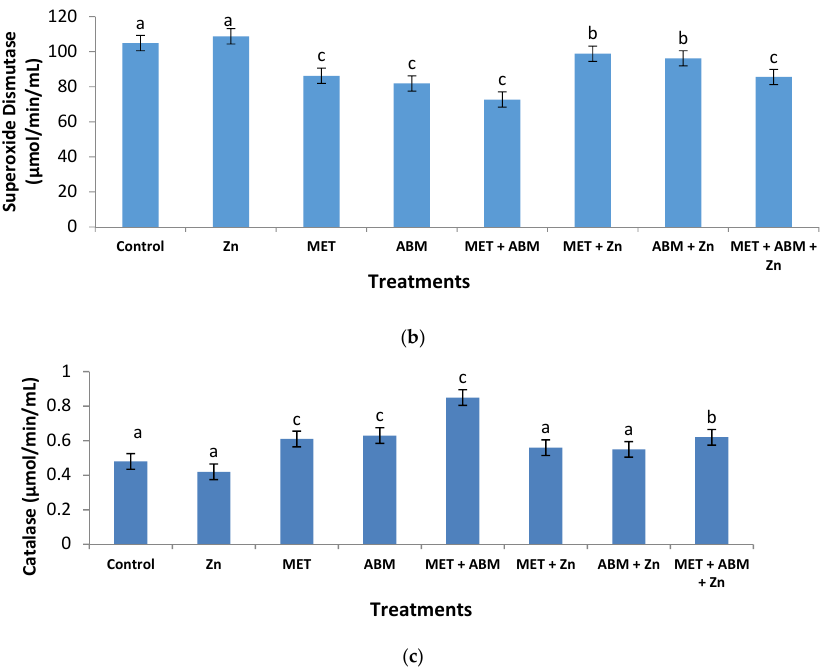
Figure 2. Effect of methomyl (MET), abamectin (ABM), and their mixture (MET+ABM), with and without zinc (Zn), on levels of malondialdehyde (MDA), superoxide dismutase (SOD), and catalase (CAT) in the plasma of male rats. Statistics: narsrepresent the group means ± SD; n = 8. Values of similar superscript letters are not statistically different. Values of superscript “b” are significantly different than those of superscript “a” at p ≤ 0.05; Values of superscript “c” are high significantly different than those of superscript “a” at p ≤ 0.01. ( a ) = malondialdehyde (MDA); ( b ) = superoxide dismutase (SOD); ( c ) = catalase (CAT).